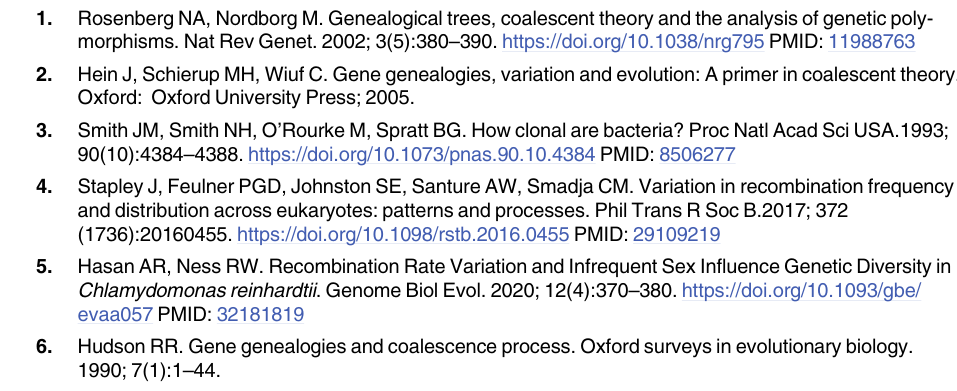
S1 Table. A. flavus isolates metadata. A. flavus isolates sampling locations, lineages, and other information for lineages IB and IC. S2 Table. All runtime parameters of ARGweaver. The results of Watterson’s theta and popu- lation recombination rate calculated by LDhat at different missing threshold levels. The parameters used when running ARGweaver. S3 Table. The posterior distribution of recombination and migration rates estimated from both the full ARG and the consensus